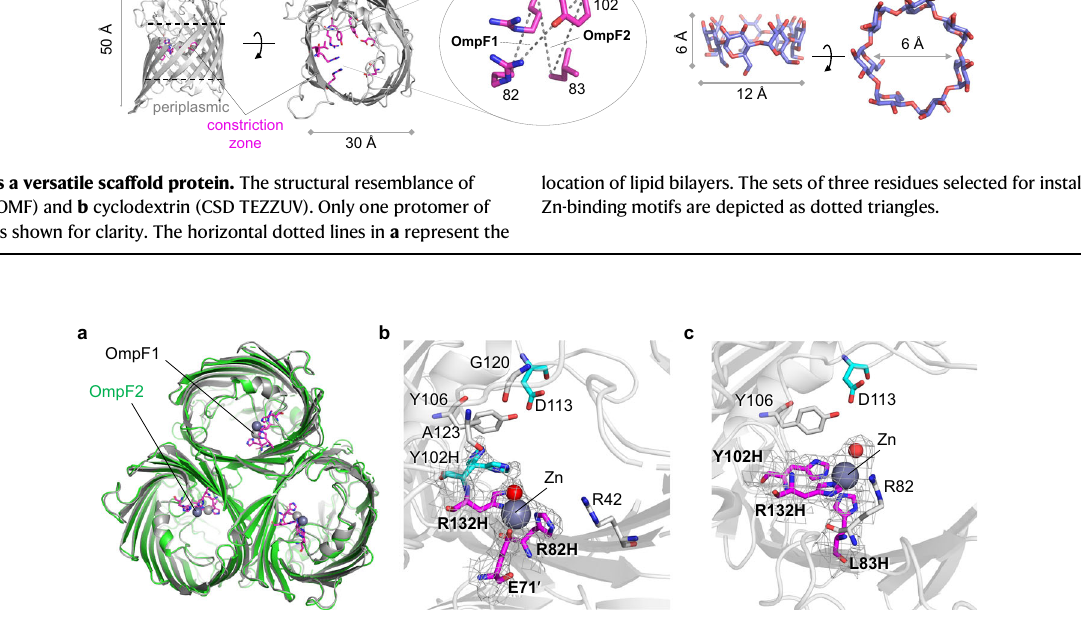
Fig. 2 | X-ray crystal structures. a The overlaid structures shown from the peri- plasmic side. The active sites of b OmpF1 and c OmpF2. Zn atoms and a metal- boundwatermoleculeareshownaslightnavyandredspheres,respectively.Metal- ligating residuesare colored inmagentaand labeled inbold.Rationallyredesigned